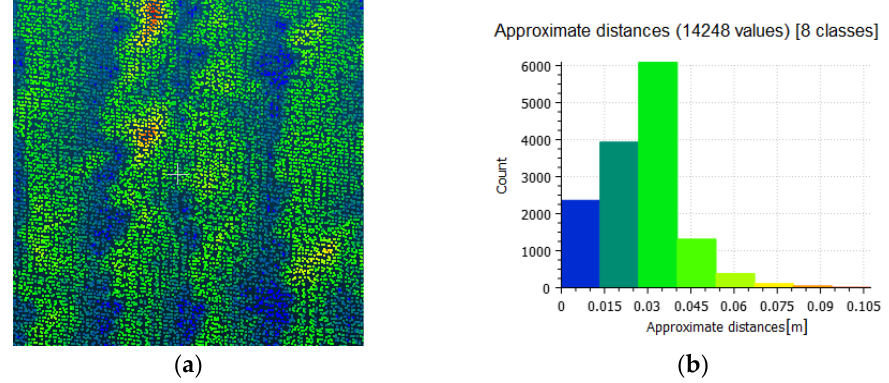
Figure 6. Data consistency analysis ( a ) Differential model of the test field located on the wall of the research facility ( b ) histogram of the distance distribution between the corresponding points on the TLS-UAV cloud planes for the test field.